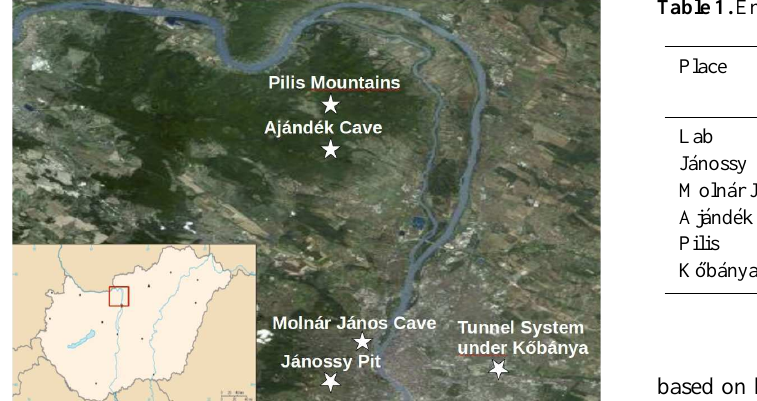
Table 1. Environmental conditions and parameters of recorded